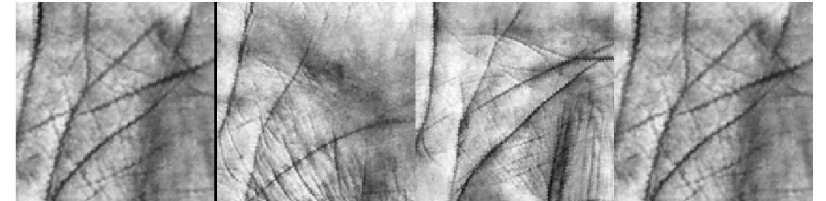
Figure 5. Sample images from the IITD database.